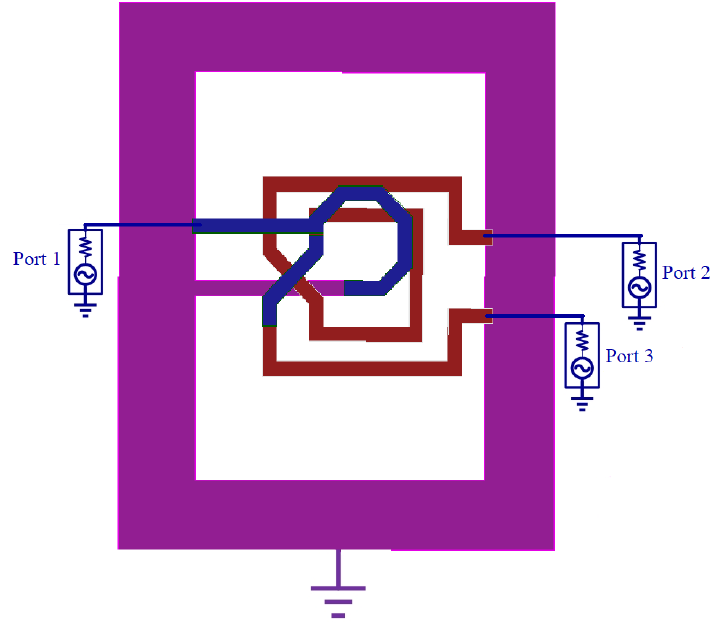
Figure 12. EM setup with layout of the input